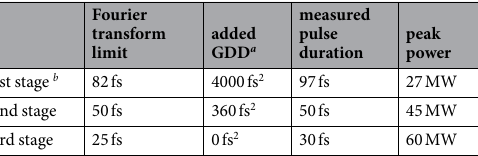
Table 1. Summary of the presented pulse compression experiments. a An additional GDD of ≈ 80 fs 2 is added by the collimation lens after each stage. b For comparison, the simulation of the 1 st stage yielding the spectrally resolved profile shown in Fig. 3(c) resulted in a 74 fs Fourier transform